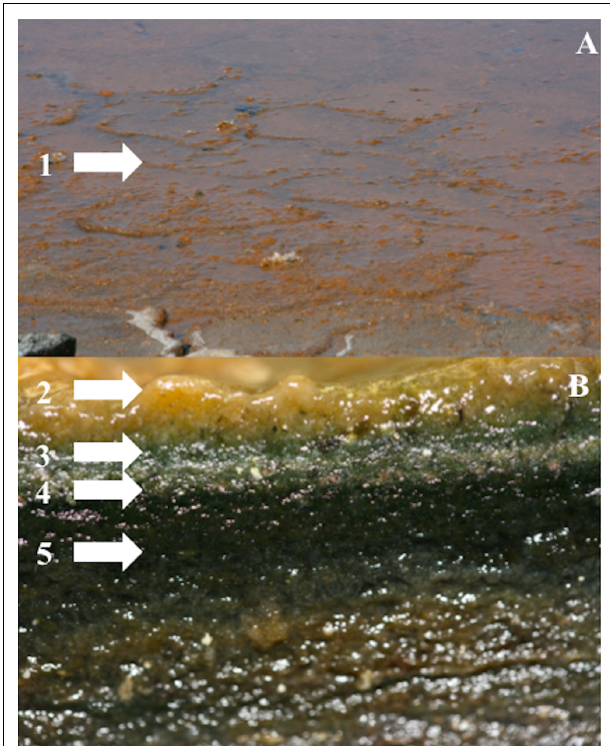
FIGURE 1 | Non-lythifying mature microbial mat from Puerto Rico. (A) View of the surface of the mat cover with an orange slime that correspond to the EPS. (B) Cross section showing the laminated structure of mat. (1–2) EPS, (3) First layer (0–1 mm), (4) Second layer (1–2 mm), (5) > 2 mm (Photos by S. A.